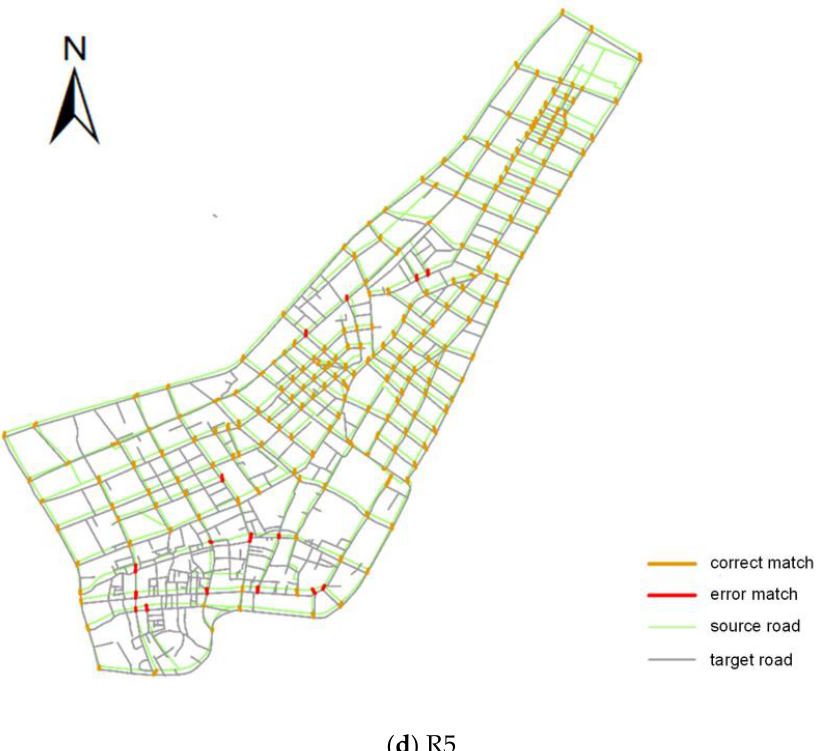
Figure A2. Matching results of DTRM for the four subregions of Area 2 (R2, R3, R4, and R5). ( a ) Matching result of R2, ( b ) matching result of R3, ( c ) matching result of R4, and ( d ) matching result of R5.